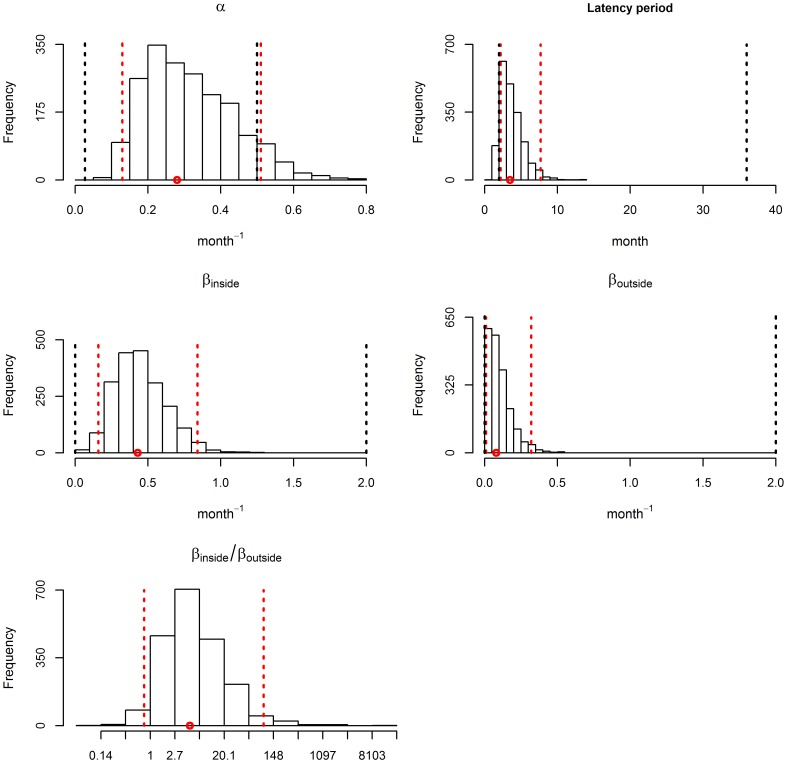
Posterior distribution of parameters α, βinside and βoutside.Red dots: median value of parameter estimates; black dotted lines: lower and higher bounds of parameter prior distributions; red dotted lines: 95% credible intervals of the parameter posterior distributions. Histogram βinside/βoutside represents the value of log ratio βinside/βoutside but the x-axis values are not expressed in log.